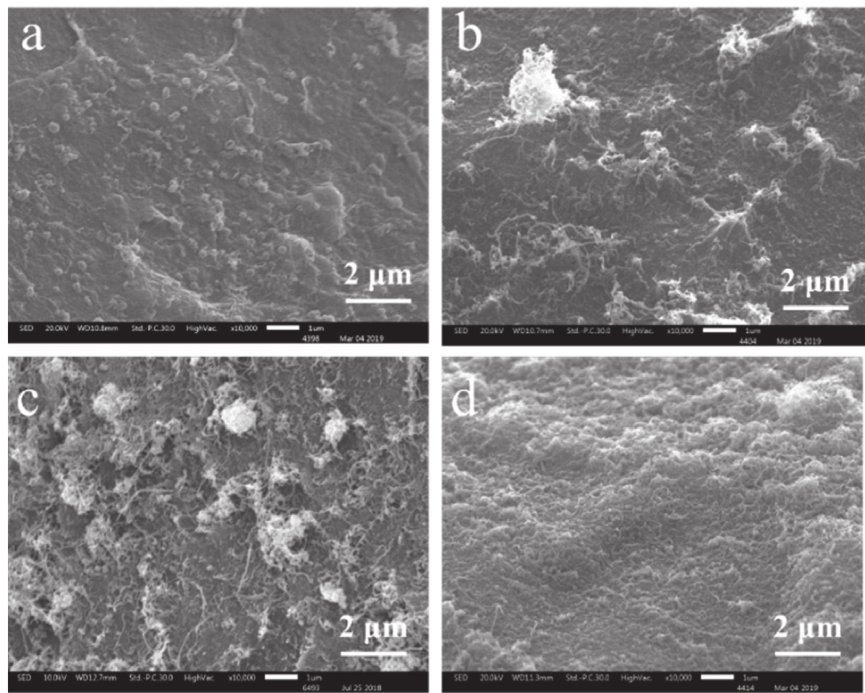
Figure 4: Surface morphology of mm-MWNTs-PDA@CaSA-Caps. MWNTs concentrations are (a) 0.1g · L − 1 , (b) 0.4g · L − 1 , (c) 0.6g · L − 1 , and (d) 1.0g · L − 1 .